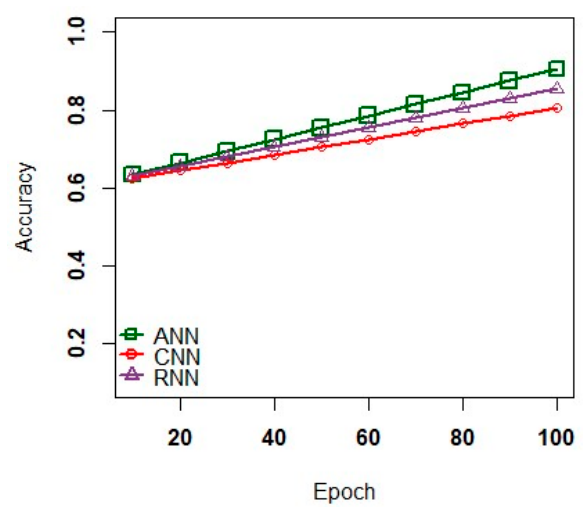
Figure 4. Model Loss versus Epoch.